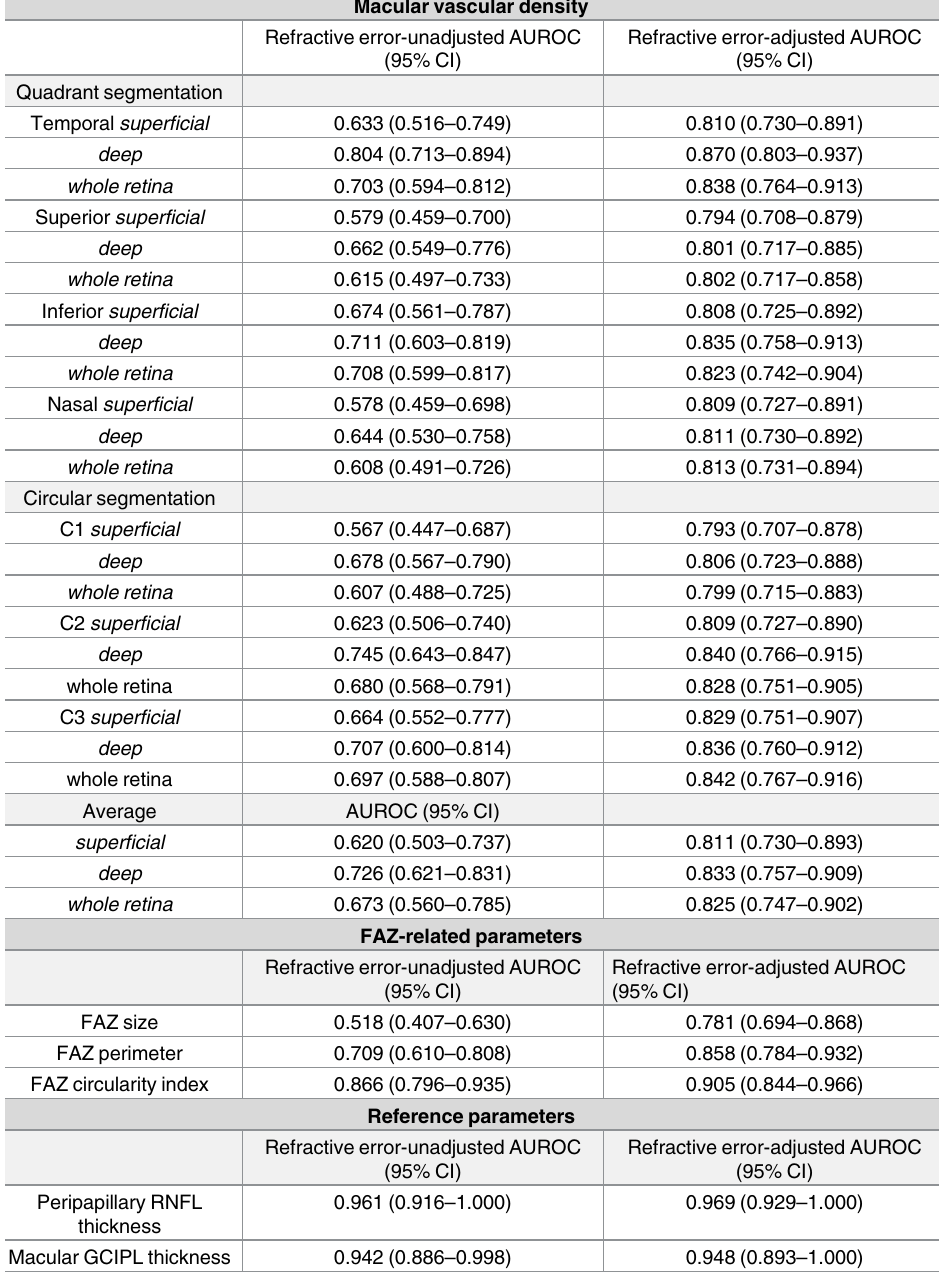
AUROC = Area Under Reciver Operating Characteristic; CI = confidence interval’ FAZ = foveal